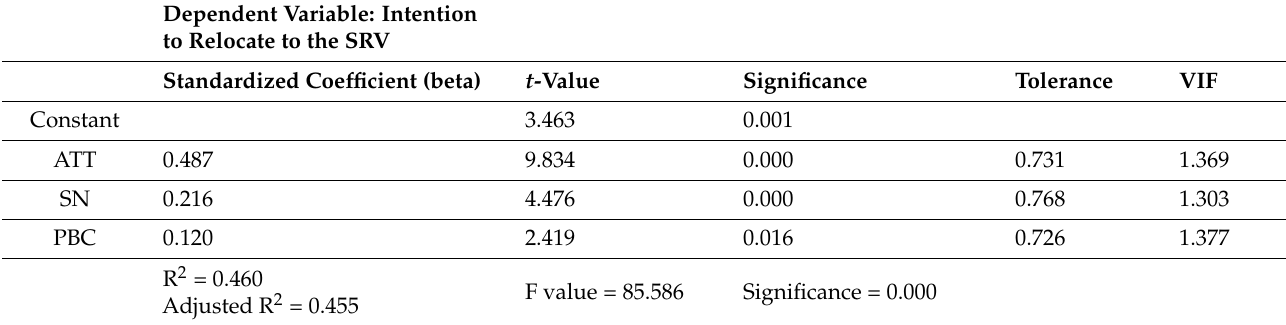
Table 4. Results of multiple regression